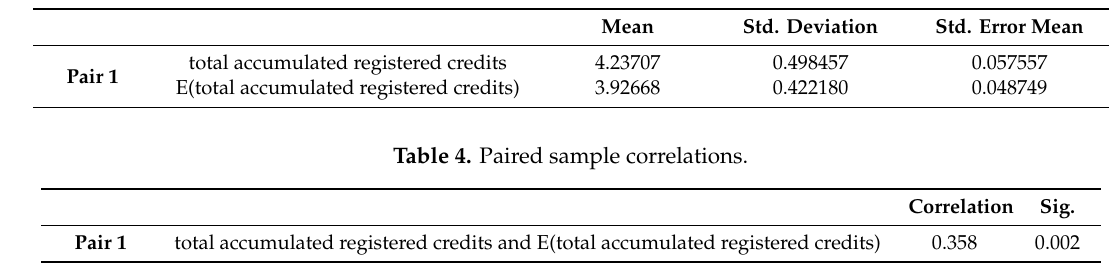
Table 3. Paired sample statistics.